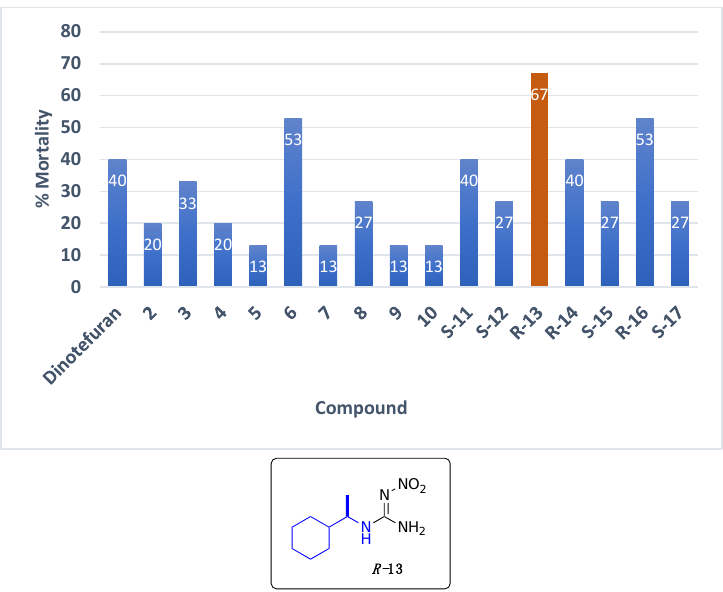
Figure 2. Analysis of non-cyclic nitroguanidines. The cyclic nitroguanidines 21 , 23 , R - 24 , R - 28 , and R - 29 showed insecticidal activities of up to 73%. The comparison between nitroguanidines 21 and 23 suggest that compounds with an electron-donating group in the para position could have a higher mortality percent than compounds that have electron-withdrawing groups. It was also observed that enan- tiopure aliphatic nitroguanidines, R - 28 and S - 29 , have a good insecticidal activity up to 73% (Figure 3).